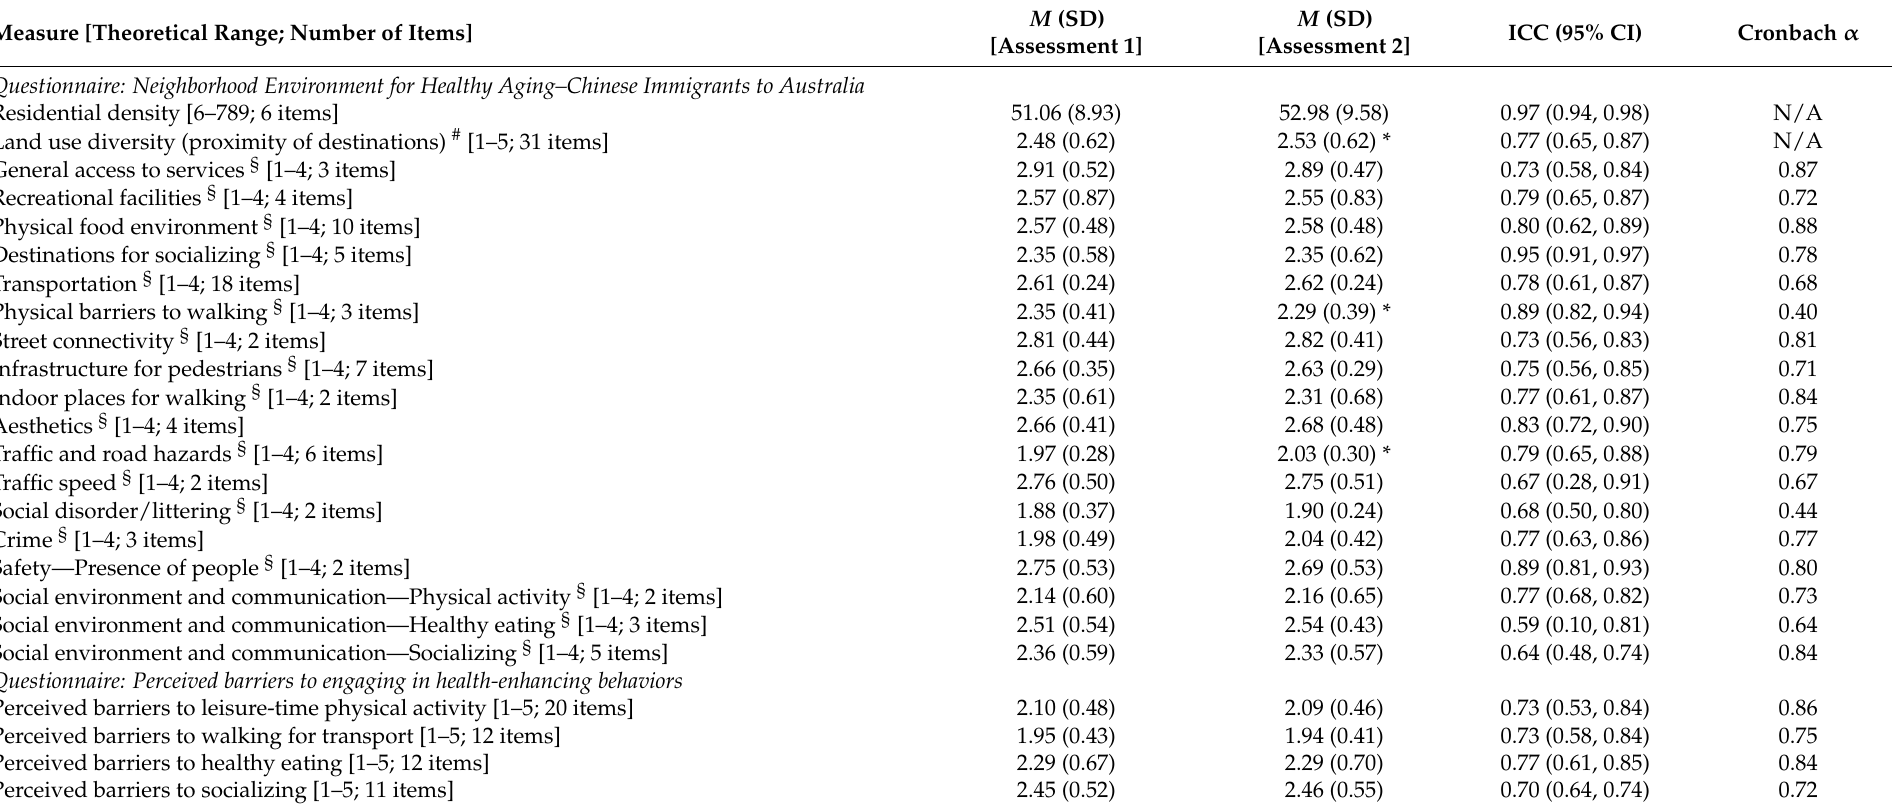
Table 5. Descriptive statistics, test-retest reliability, and internal consistency of measures of perceived neighborhood environmental attributes influencing, and perceived barriers to engagement in, healthy behaviors for older Chinese immigrants to